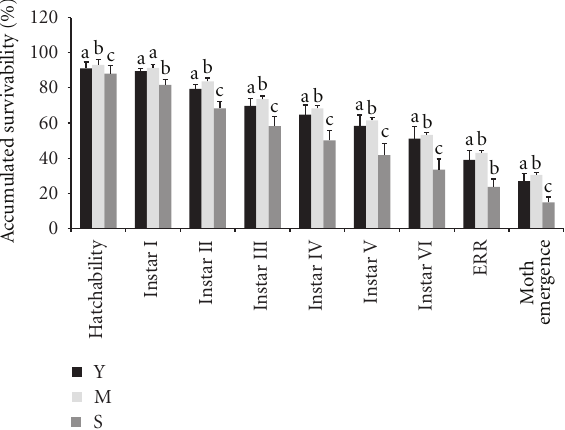
Figure 2: Accumulated survivals of D. casignetum on young (Y), mature (M) and senescent (S) sunflower leaves. Means ± SE of five observations. The di ff erent letters over the bars indicate that the means are significantly di ff erent at P < 0 .